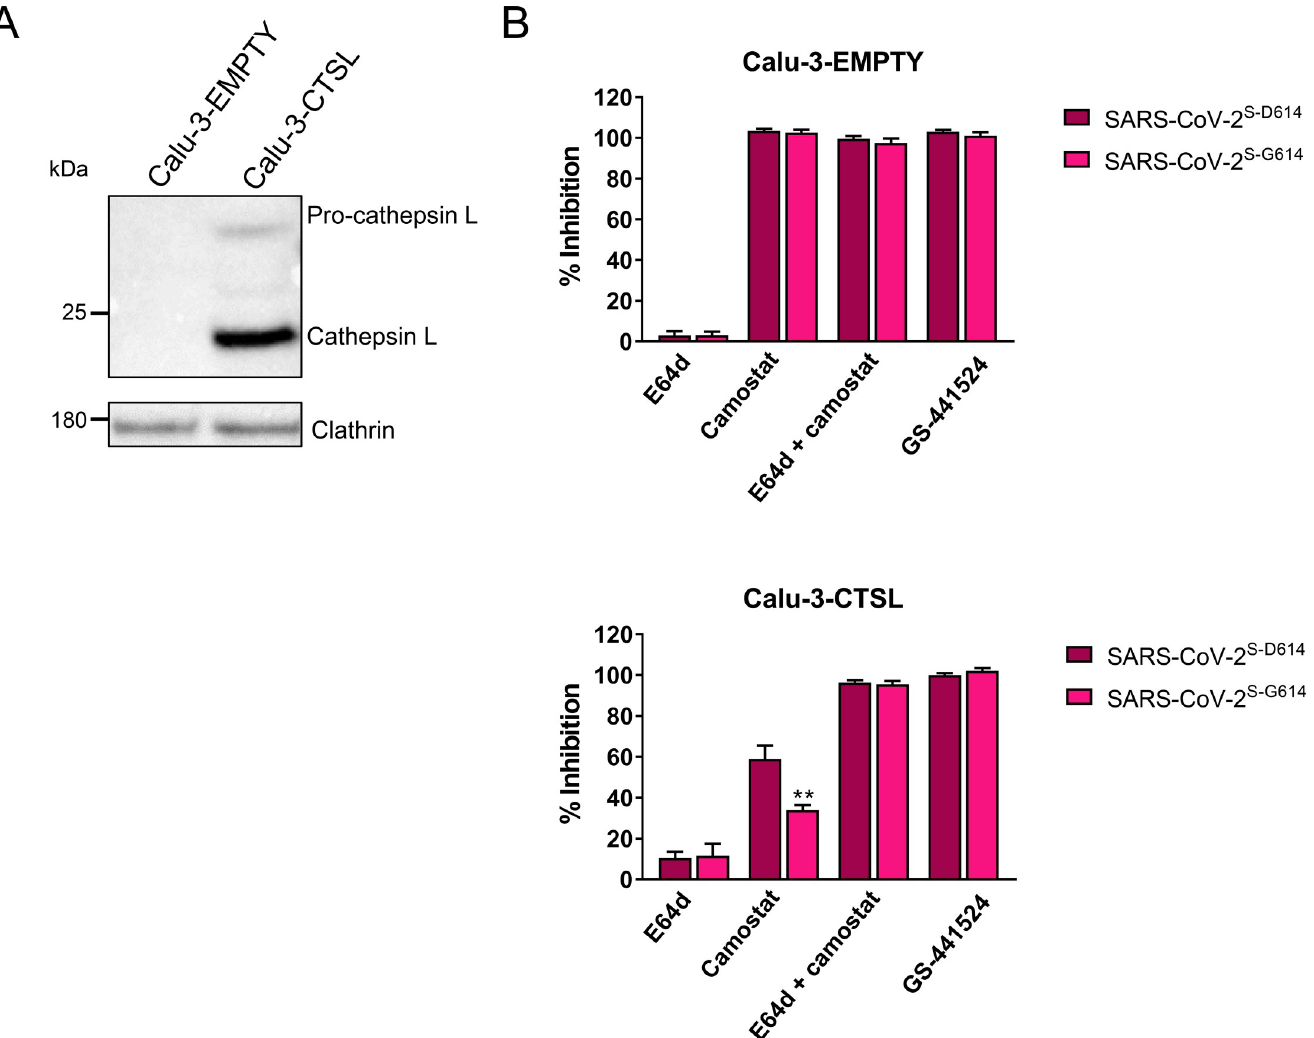
Fig 6. Virus bearing variation S G614 is more effective at using the cathepsin L route. Control (Calu-3-EMPTY) and cathepsin L-expressing (Calu-3-CTSL) Calu-3 cells were (A) checked for expression of cathepsin L and (B) infected with SARS-CoV-2 virus bearing spike variation D614 or G614, in the presence of 20 μ M E64d; 100 μ M camostat; 100 μ M camostat plus 20 μ M E64d; or 10 μ M GS-441524. At 3 days p.i., the inhibitory effect of the compounds on virus replication was quantified by immunofluorescence for dsRNA. �� , P � 0.01 (unpaired two-tailed t-test; SARS-CoV-2 S-G614 versus SARS-CoV-2 S-D614 ). Results are the mean ± SEM from three